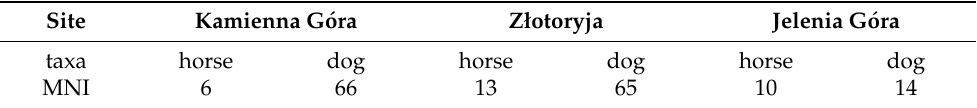
Table 3. The minimum number of individuals (MNI) estimated for horses and dogs from early